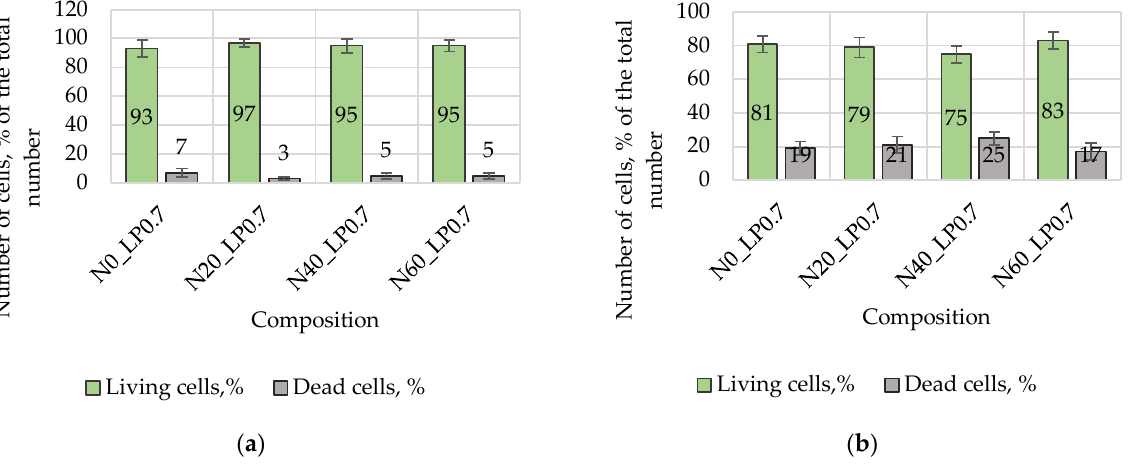
Figure 10. Cytotoxic effect of ceramics after 24 ( a ) and 96 h ( b ) of cultivating mesenchymal stromal cells of human bone marrow on them.